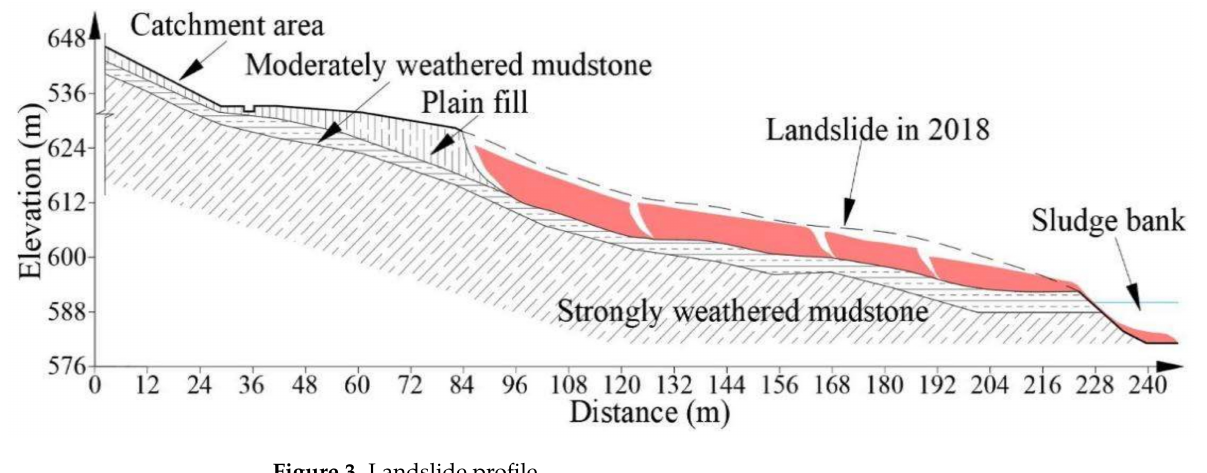
Figure 3. Landslide profile.